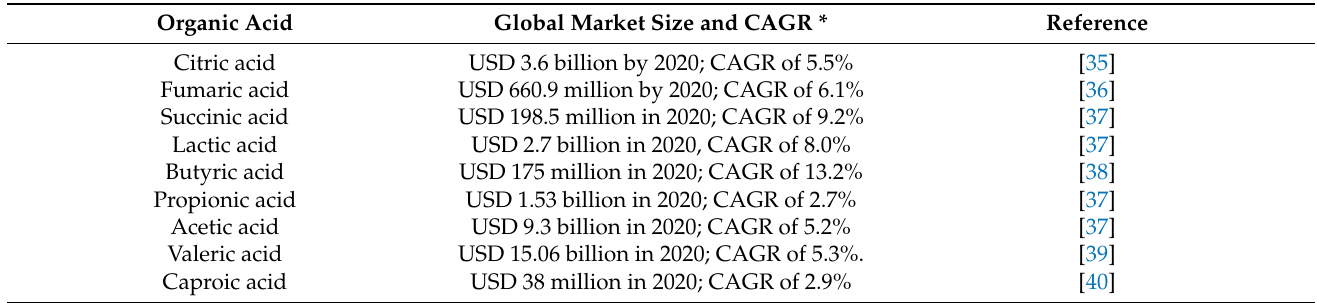
Table 2. Global market sizes of important organic